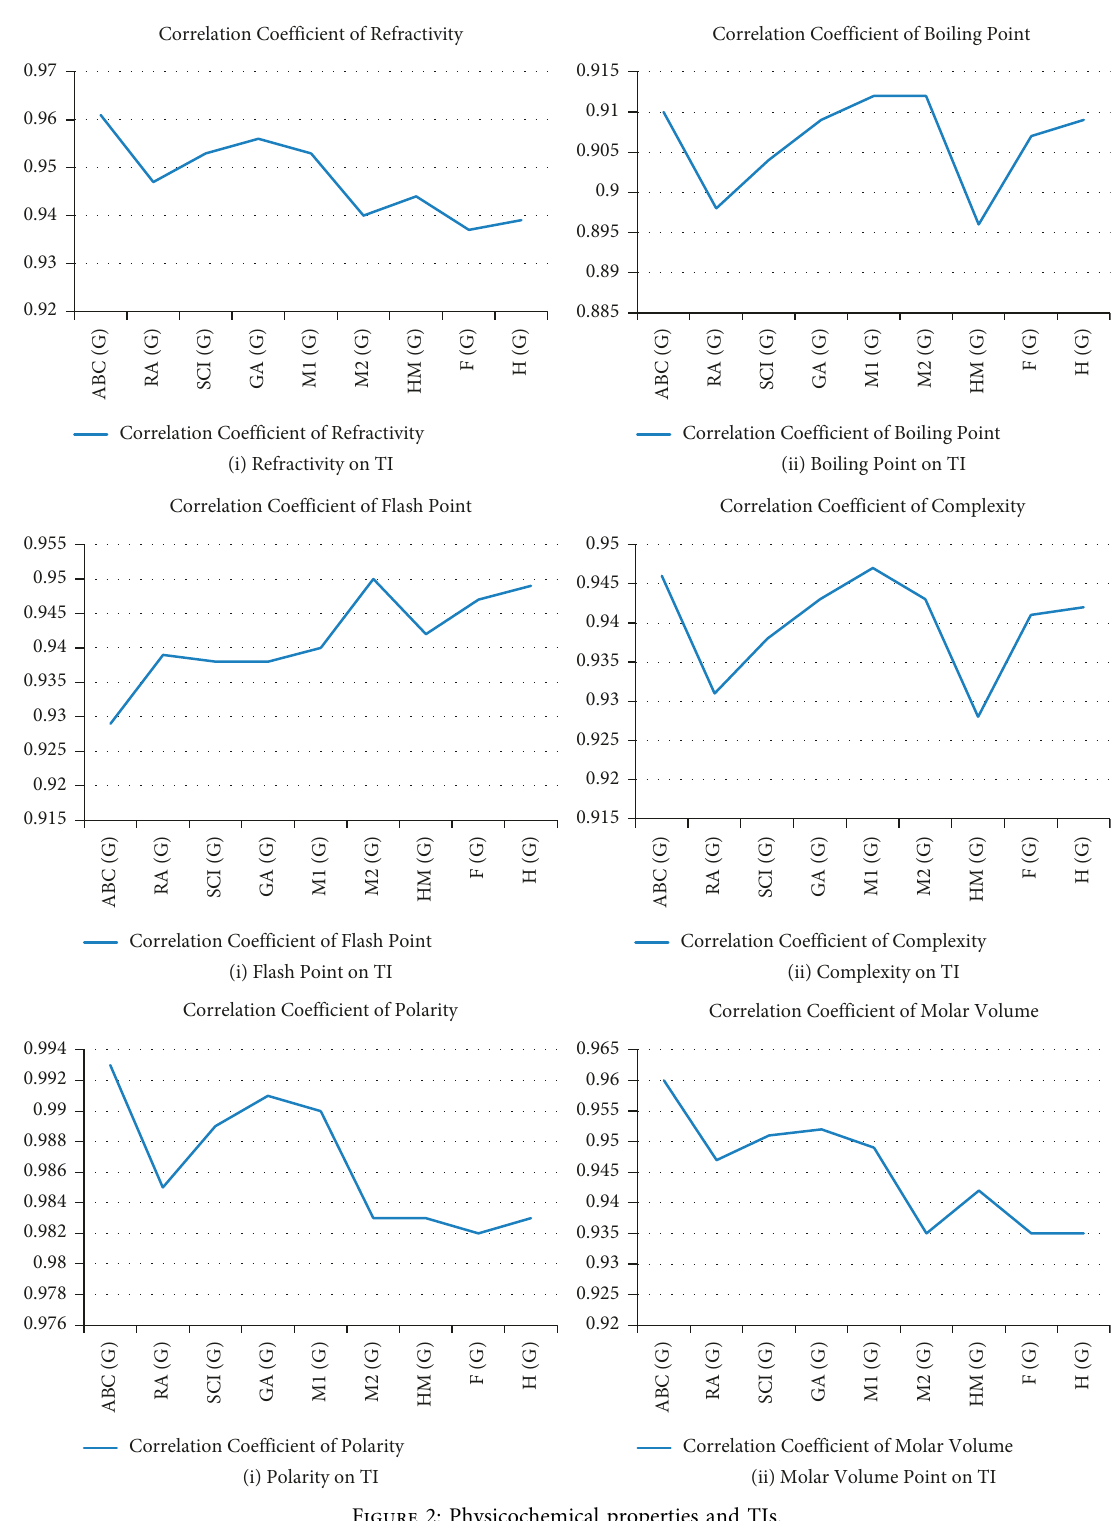
Figure 2: Physicochemical properties and